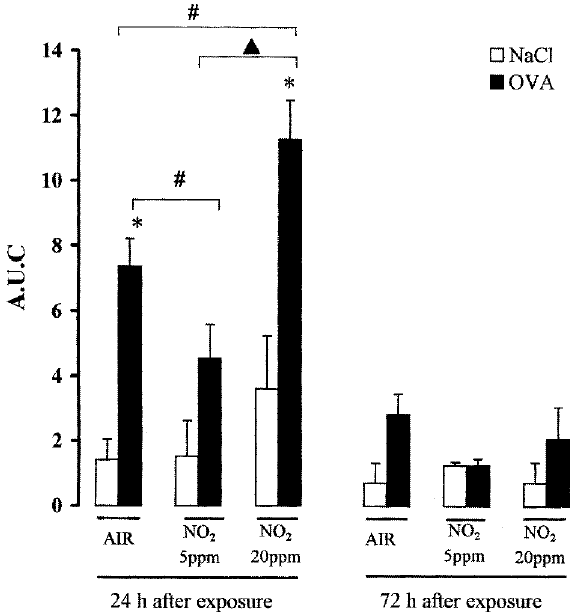
FIG. 1. BHR is significantly augmented in immunized mice exposed to 20ppm NO 2 . At day 14, immunized mice were challenged i.n. with saline ( h ) or OVA ( j ) and were exposed to 5 or 20ppm NO 2 or to air for 3h. At days 15 (24h) and 17 (72h), BHR in response to methacholine was evaluated. The graphic in terms of area under the curve (A.U.C) represents the quantitative expression of BHR. Data are expressed as the mean ± SEM. * p £ 0.05, OVA-challenged mice compared with their saline control; # p £ 0.05, OVA-air group compared with the NO 2 -OVA group (5 or 20ppm); m p £ 0.05, 5ppm NO 2 -OVA group compared with the 20ppm NO 2 -OVA